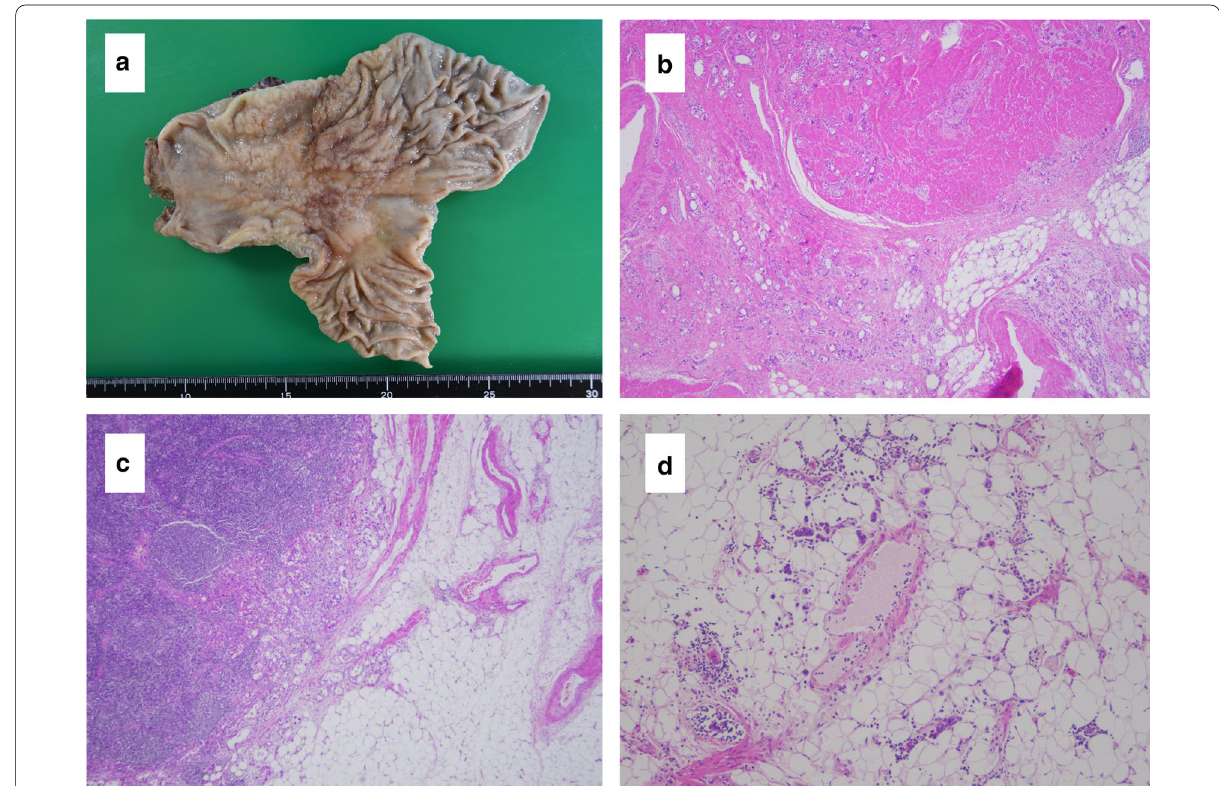
Fig. 1 Macroscopic and microscopic appearance of the resected stomach. a Resected specimen reveals a circumferential type 3 tumor mainly at the antrum of the stomach. An ulcer scar can be seen in contact with the tumor. The oral and anal margins were 50 mm and 30 mm, respectively. The resection margin was negative. b Tumor invaded the subserosa, and there was no apparent exposure to the serosal surface (H&E staining, c , d Poorly differentiated adenocarcinoma invaded the adipose tissue from the lymphatic vessels and veins around the metastatic lymph nodes (H&E staining, ×